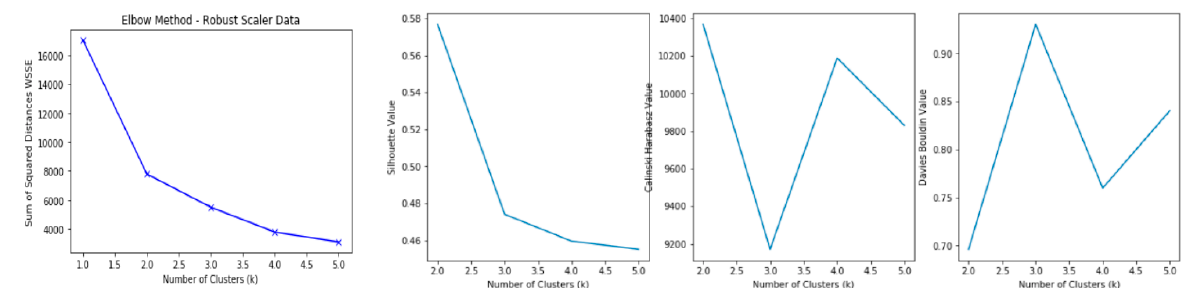
Figure 14. Metrics change for the robust-scaled data.